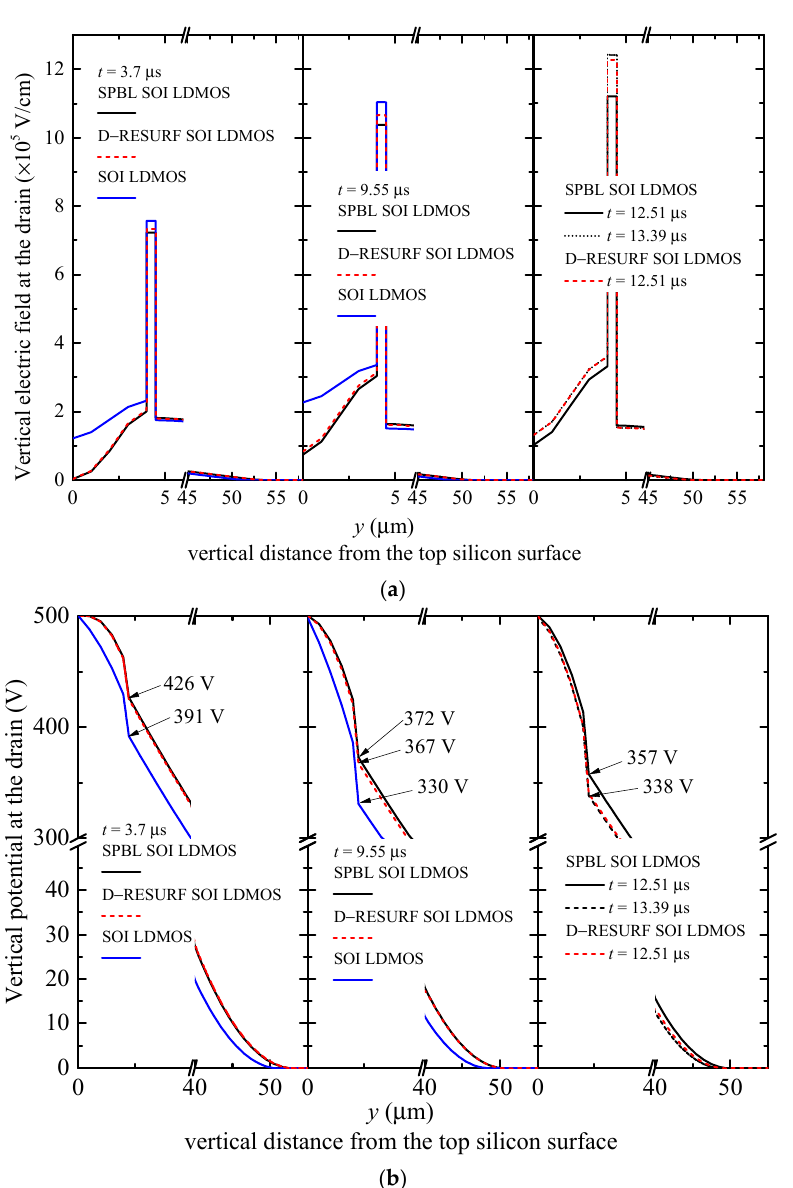
Figure 8. Distribution of vertical electric field and potential at the drain of the SPBL SOI LDMOS, D − RESURF SOI LDMOS and SOI LDMOS at different time points ( T = 373 K, V d = 500 V): ( a ) vertical electric field distribution and ( b ) vertical potential distribution.